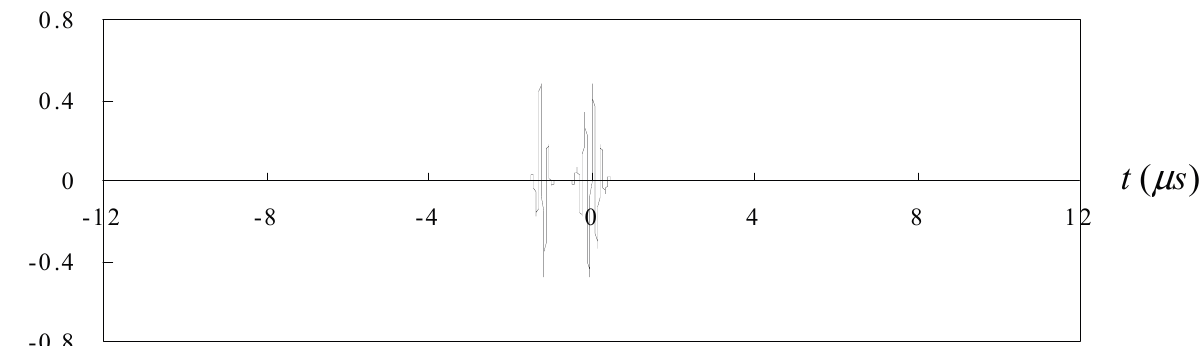
Figure 5. Two pulses with time